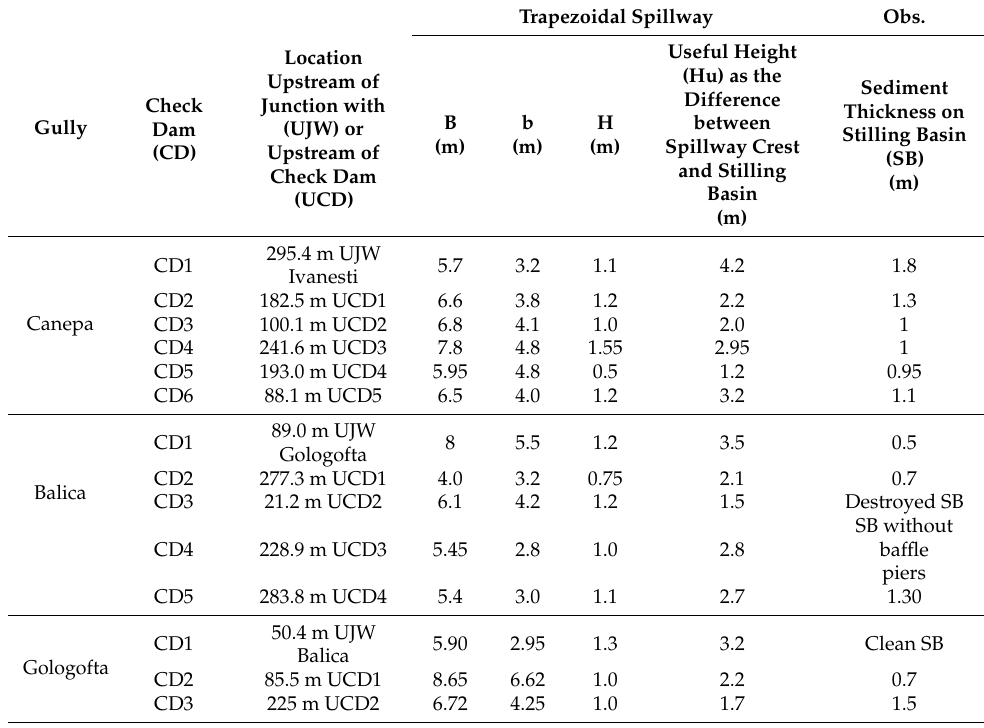
Table A3. Some parameters of 18 gully cross-sections from the Ivanesti sub-catchment, Moldavian Plateau, Romania. Gully